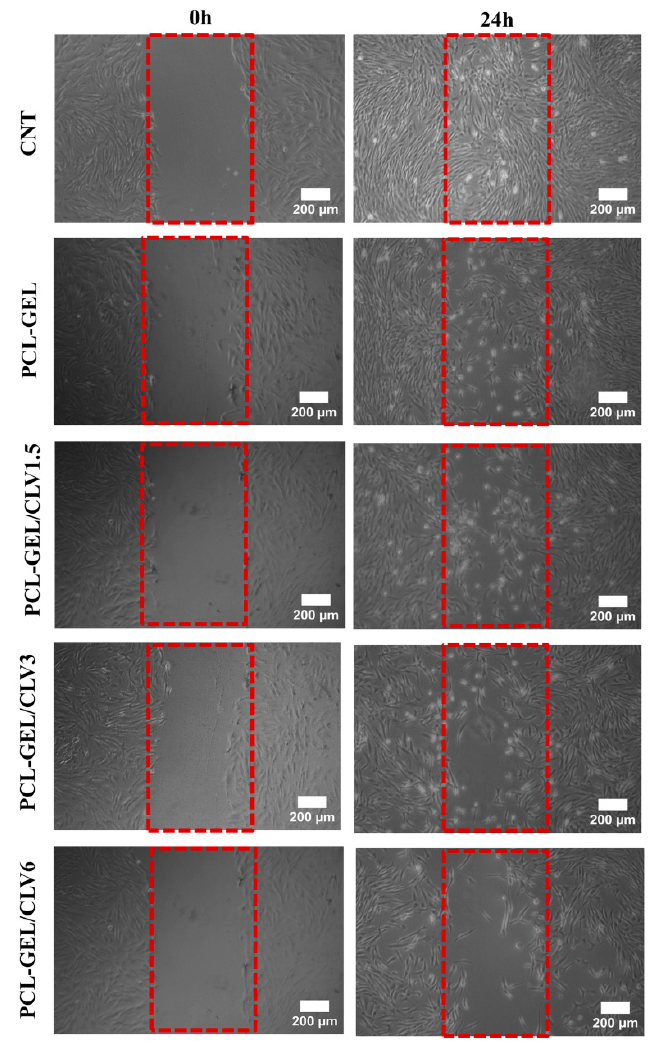
Figure 7. Illustrative micrographs of cell migrating into a scratch area over a 24 h period in CNT, PCL-GEL, PCL-GEL/CLV1.5, PCL-GEL/CLV3, and PCL-GEL/CLV6.